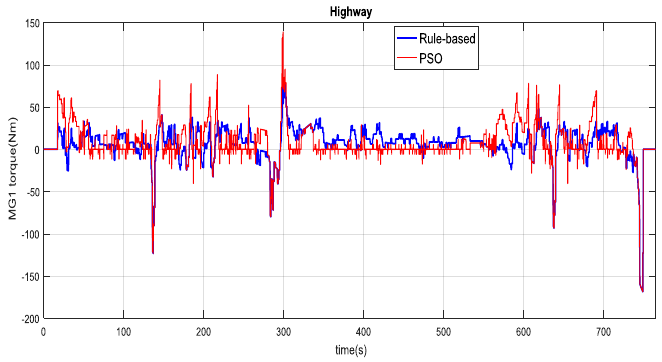
Figure 21. M/G1 torque in the highway driving cycle.